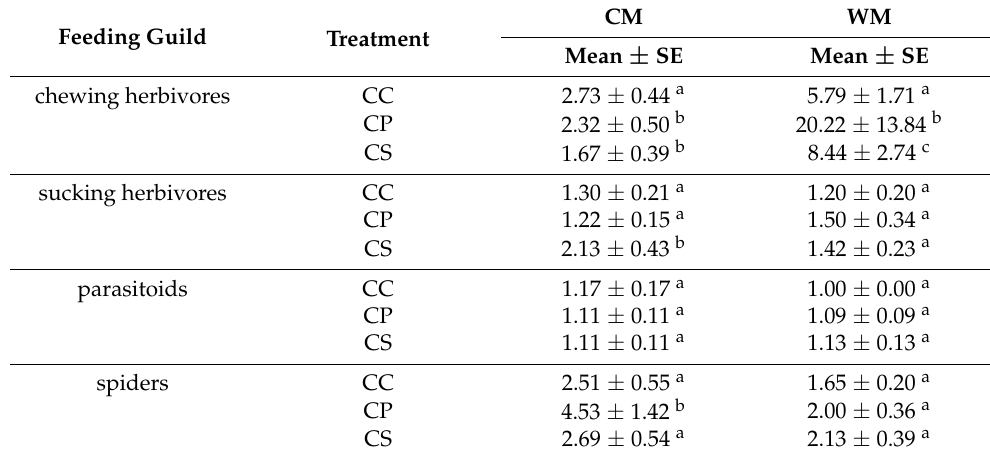
Table 3. Cont. Feeding